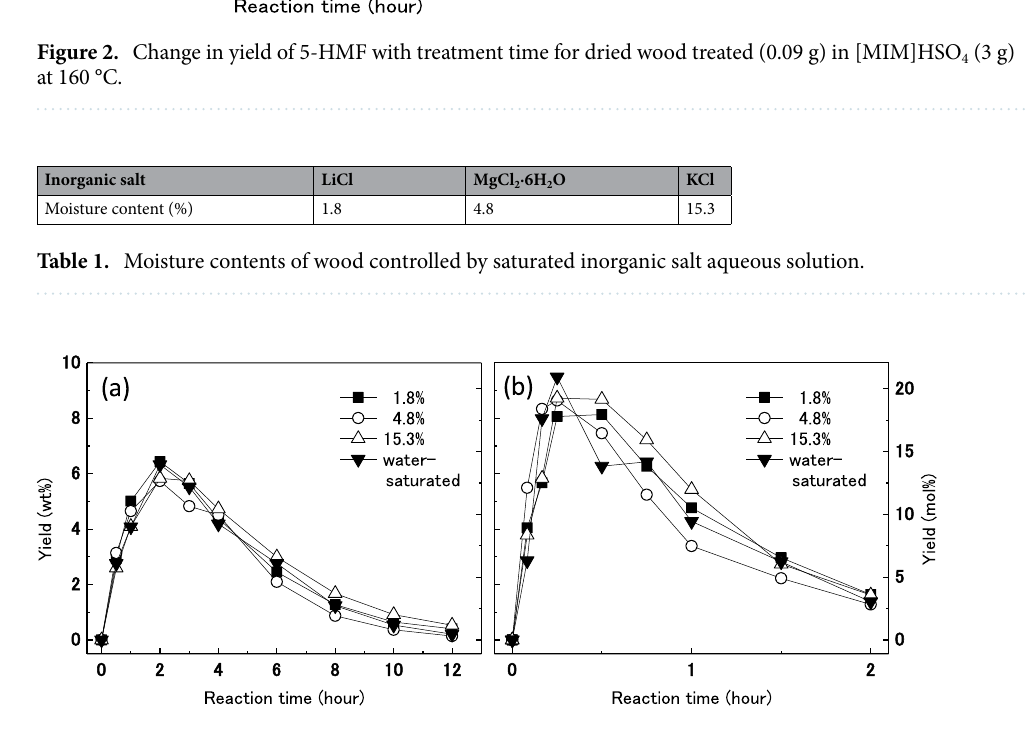
Figure 3. Changes of yields of 5-HMF with treatment time for humidified wood (0.09 g) treated in [MIM] HSO 4 (3 g) at ( a ) 140 °C and ( b ) 160